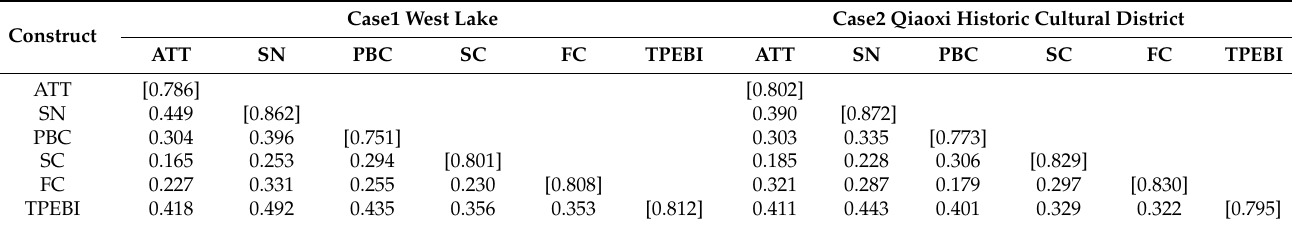
Table 3. Results of the discriminant validity.